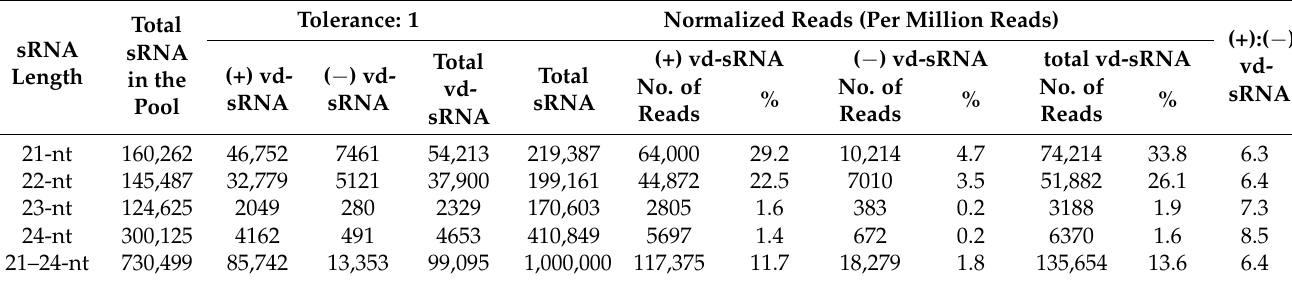
compared to the zero-tolerance mapping. Analyzing the vd-sRNAs derived from both the genomic and the antigenomic strands revealed that genomic strand-derived sRNAs were expressed at least 6.4 times higher than the antigenomic strand-derived sRNAs. Table 5. Summary of the sRNAs identified by NGS from PSTVd-RG1-inoculated tomato plants cv. Rutgers at one mismatch with the PSTVd-RG1 genome.